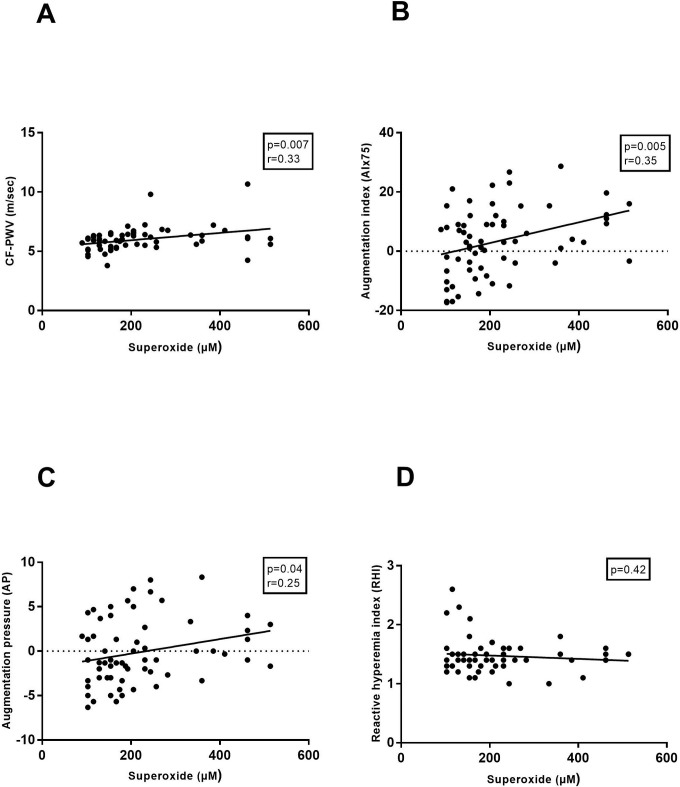
Correlation of superoxide concentrations with vascular function in the third trimester of a healthy pregnancy.Vascular function was assessed by carotid-femoral pulse wave velocity (CF-PWV (6.2±0.8), Fig 2A), augmentation index 75 (AIx75 (4.4±11.7), Fig 2B), augmentation pressure (AP (0.3±4.1), Fig 2C) and reactive hyperaemia index (RHI (1.6±0.4), Fig 2D). (r: pearson correlation coefficient).